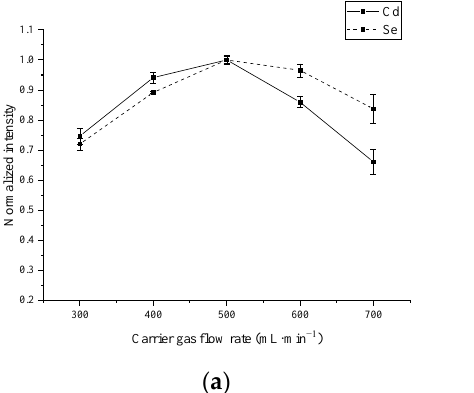
Figure 3. Cd and Se signal peaks with the increase of ETV heating time (temperature). The operating parameters of ETV monitoring are shown in Table S3. A rice sample (GBW10010a, Cd = 53 ± 4 ng·g −1 and Se = 36 ± 8 ng·g −1 ) was employed for slurry sampling.